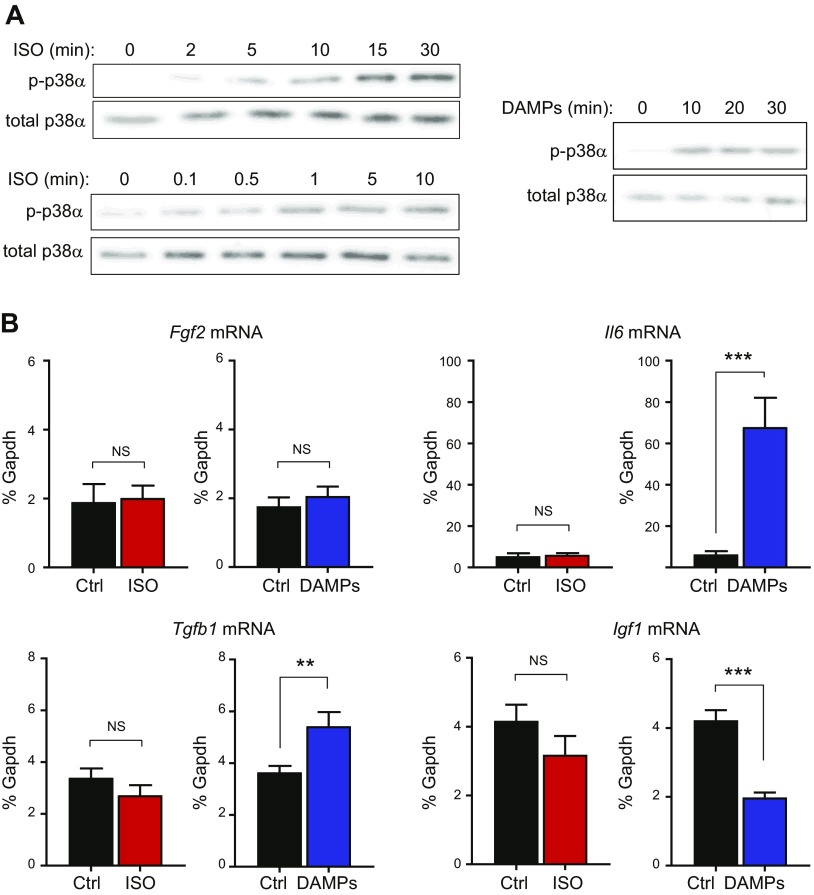
Effects of isoproterenol and cardiac DAMPs on p38α activation and expression of hypertrophy-inducing factors in cultured cardiac fibroblasts. A) Western blotting of phosphorylated (activated) p38α and total p38α expression showing time of response to 5 μM ISO, concentration response to 0.1–10 μM ISO after 15 min, and time of response to cardiac DAMPs. Blots are representative of 3 separate experiments. B) Real-time RT-PCR data showing effect of ISO (5 μM, 6 h, n = 8) or cardiac DAMPs (6 h, n = 12) on mRNA expression of Fgf2, Il6, Tgfb1 and Igf1. Data expressed as percentage Gapdh mRNA levels. **P < 0.01, ***P < 0.001. NS, not significant (paired-ratio Student’s t test).